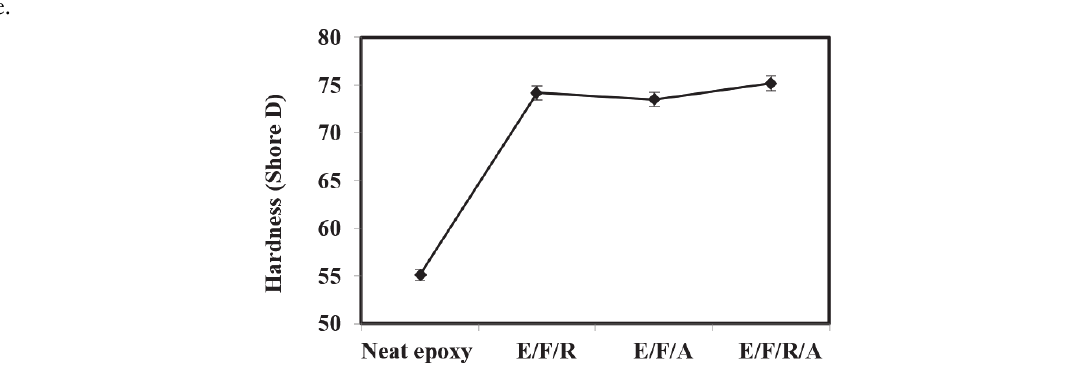
Figure 7: Hardness values of hybrid composites